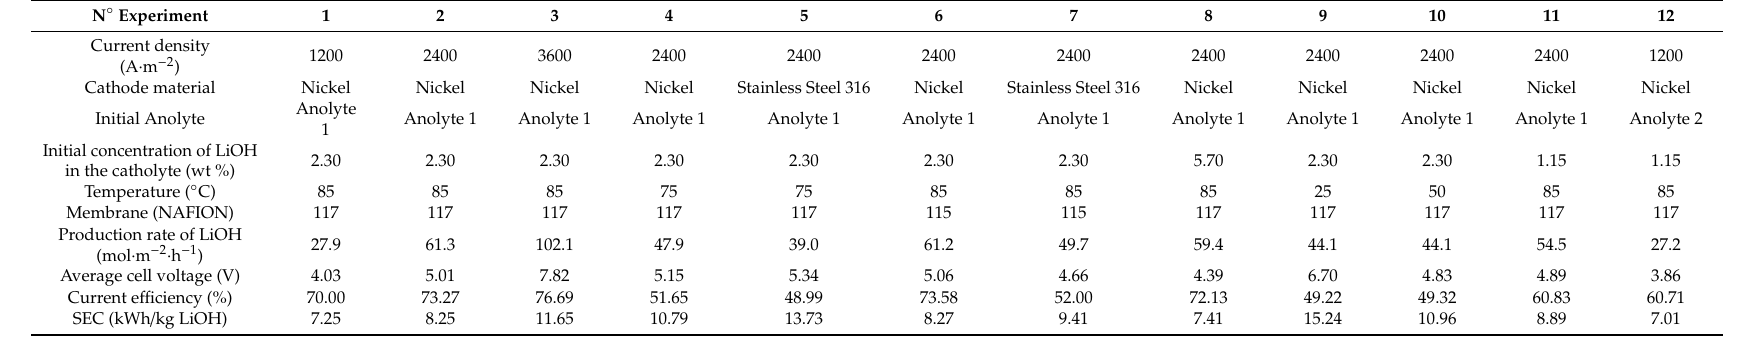
Table 3. Results obtained in each experiment with membrane electrodialysis